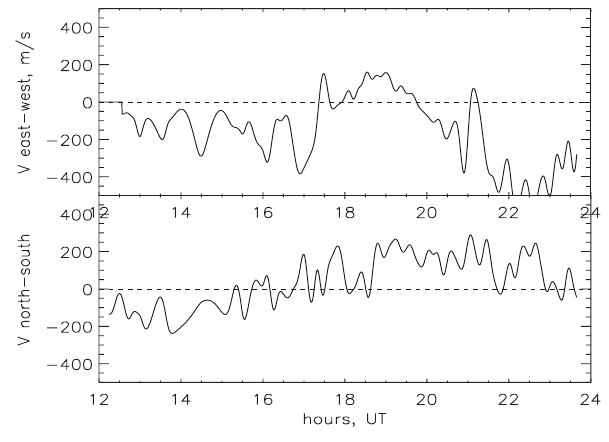
Figure 1 Cambridge Bay data sample, 28 Feb. 1996. The top panel shows the reflections on 3.18 MHz frequency, and the bottom two panels shows the east-west and north-south convection velocities.